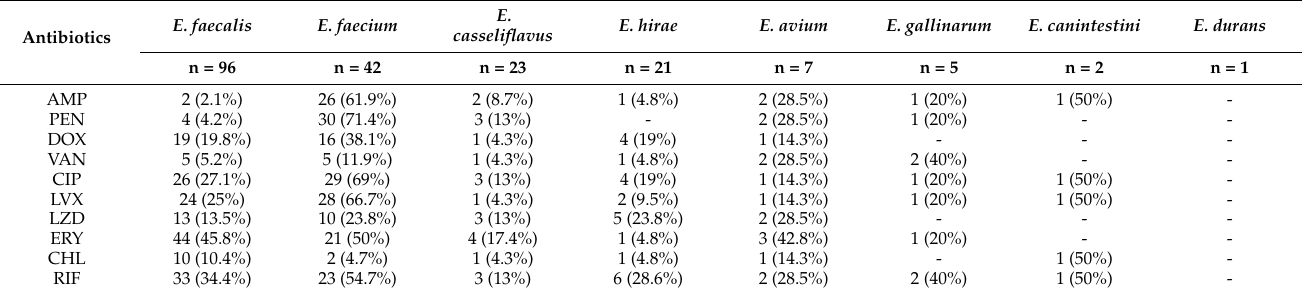
Table 1. The prevalence of antimicrobial resistance in Enterococcus strains isolated from chronic otitis externa in dogs.